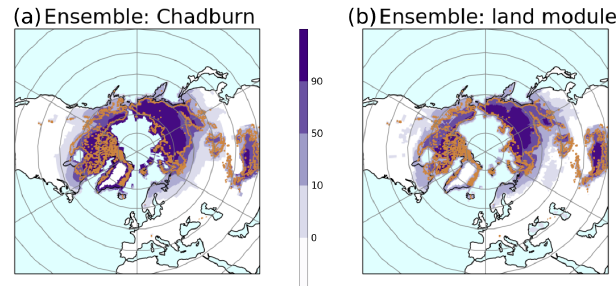
Figure 4. (a) The multi-model probability of permafrost using the Chadburn et al. (2017) relationship for each model (PF benchmark ). (b) The multi-model probability of permafrost where permafrost is defined by the temperature at the D zaa or the lowest model level for the models with the shallower soil profile (PF ex ). These plots are the mean for 1995–2014. The orange lines are the limits for 50% permafrost from the CCI-PF data (Obu et al.,